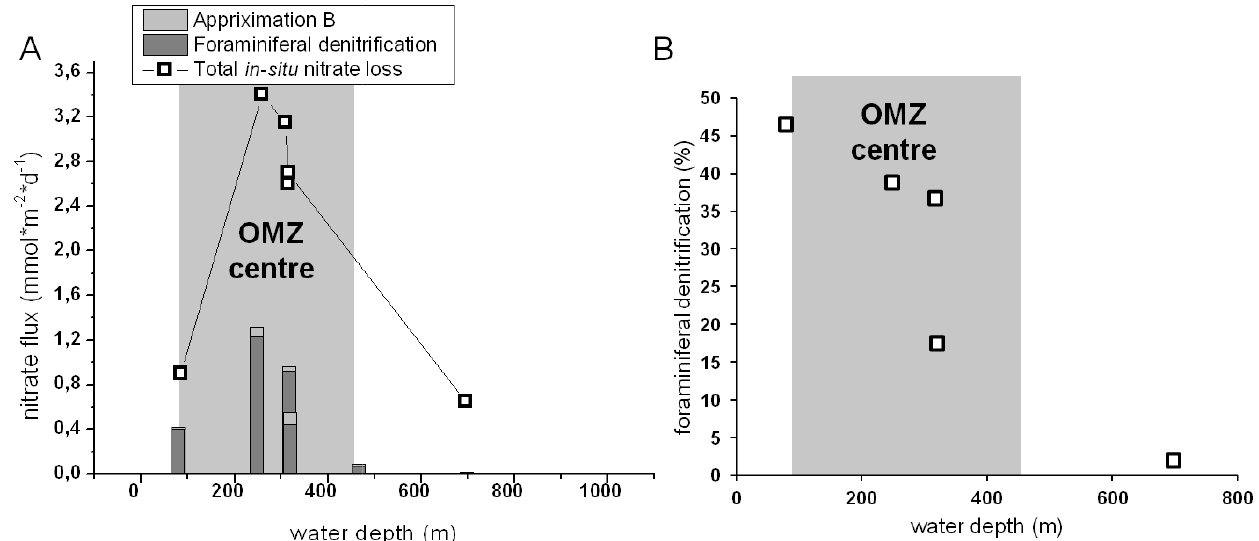
Fig. 3. (A) Comparison of benthic foraminiferal denitrification rates to the total in situ benthic NO − both plotted against water depth. (B) Percentage of the contribution of foraminiferal denitrification to the total in situ benthic NO − : Comparison of benthic foraminiferal dentrification rates to the total : Comparison of benthic foraminiferal dentrification rates to the total in-situ Figure 3: A : Comparison of benthic foraminiferal dentrification rates to the total